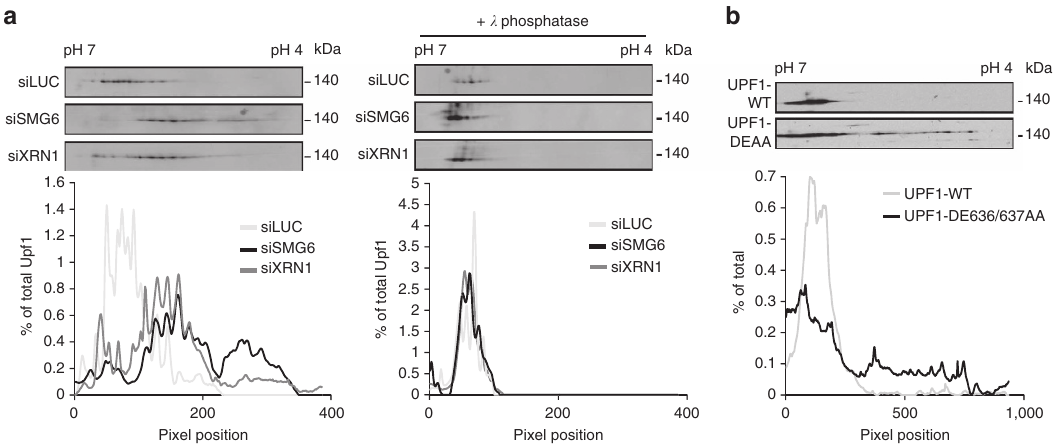
Figure 2 | UPF1 is hyperphosphorylated upon SMG6 and XRN1 depletion and upon inhibition of ATPase activity. ( a ) Two-dimensional gel electrophoresis assays performed on extracts from HeLa tet-off cells transfected with siRNAs targeting Firefly Luciferase (siLUC), SMG6 (siSMG6) or XRN1 (siXRN1) and subjected to western blotting with anti-UPF1 antibody. Prior to electrophoresis, cell lysates were treated ( þ l phosphatase; right panel) or not (left panel) with lambda protein phosphatase. Graphs indicate signal intensity along the blots normalized to the total signal intensity. ( b ) Two-dimensional gel electrophoresis assays performed on extracts from HeLa tet-off cells transfected with plasmids coding for myc-tagged wild-type UPF1 (Upf1-WT) or UPF1 DE636/637AA. The graph indicates signal intensity along the blots normalized to the total signal intensity.